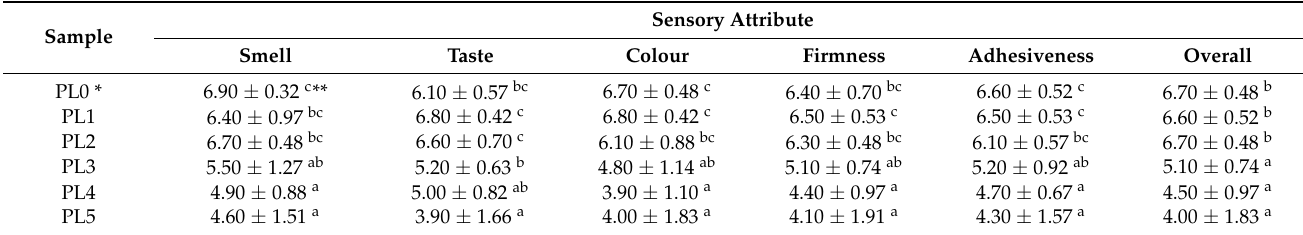
Table 5. Sensory characteristics of cooked pasta fortified green leek